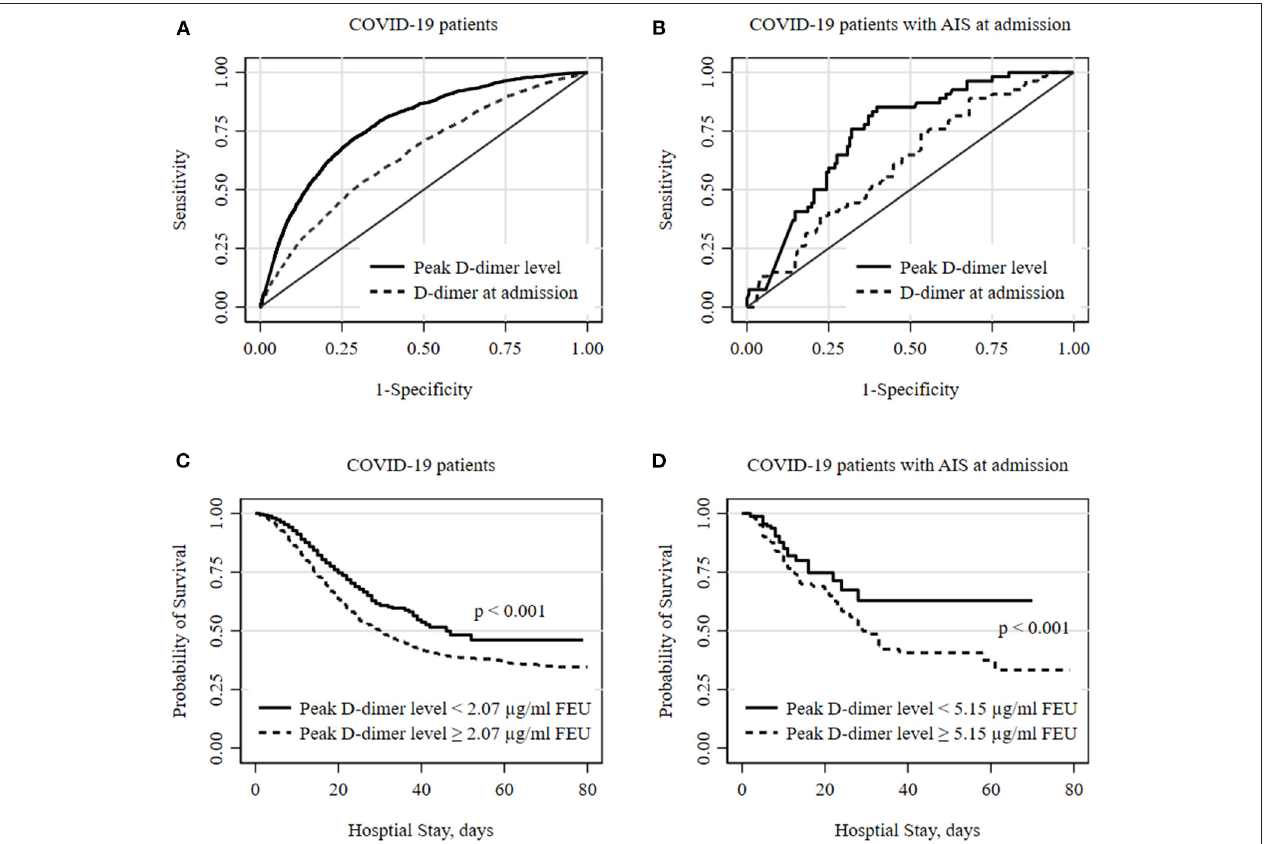
FIGURE 1 | Optimal D-dimer levels to predict in-hospital mortality among COVID patients. (A,B) show receiver operator characteristic (ROC) curves for optimal D-dimer levels to predict deaths in all COVID-19 hospitalized patients and subgroup of patients with acute ischemic stroke (AIS) at admission. The peak D-dimer level performs better to predict deaths compared to D-dimer level at admission. The optimum cutoff thresholds of peak D-dimer levels were defined as the point on the ROC curve nearest to the upper left corner (0, 1) and were 2.07 µ g/ml FEU with 72.3% sensitivity and 69.8% specificity for all and 5.15 µ g/ml FEU with 72.6% sensitivity and 68.7% of specificity for AIS subgroup. (C,D) show Kaplan-Meier survival curves for all-cause death during hospital stay. Cutoff values of 2.07 and 5.15 estimated from ROC analyses were used for all and a subgroup of patients with AIS at admission, respectively. Statistical differences in survival curves between peak D-dimer levels below and above the cutoff values were assessed using a log-rank